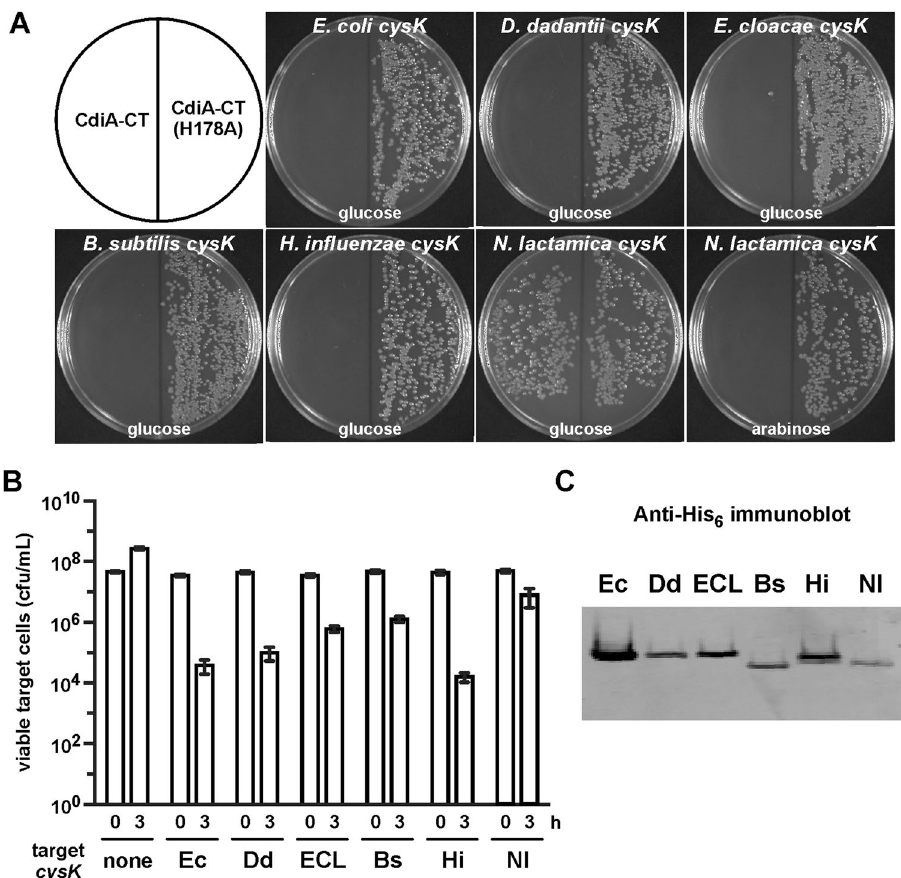
Figure 5. Heterologous CysK promotes CdiA-CT toxicity. ( A ) Activation of internally expressed CdiA-CT toxin. Plasmids encoding CdiA-CT and CysK proteins were introduced into E. coli ∆ cysK cells, and transformants isolated on selective media supplemented with D-glucose or L-arabinose as indicated. To control for transformation efficiency, a plasmid encoding catalytically inactive CdiA-CT(H178A) was also tested. ( B ) CDI competition co-cultures. Inhibitor cells that deploy CdiA-CT were incubated with E. coli ∆ cysK target bacteria that express CysK-His 6 from the indicated bacterial species. Viable target bacteria were quantified as colony forming units per mL upon mixing and after 3 h of co-culture. Presented data are averages ± standard errors for four independent experiments. ( C ) Immunoblot analysis of heterologous CysK-His 6 . Total protein was isolated from the target-cell strains in panel B and analyzed by immunoblotting using antibodies to the His 6 epitope. 10 μ g of total protein was loaded in each